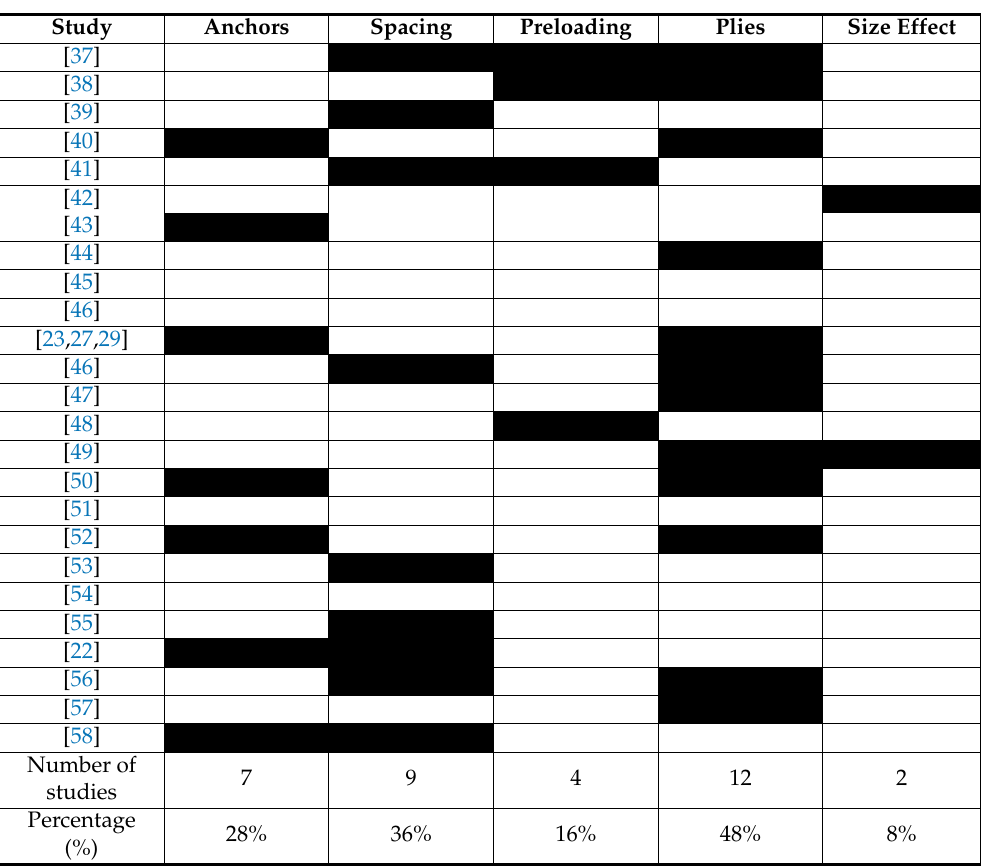
Table 3. Parameters investigated by various